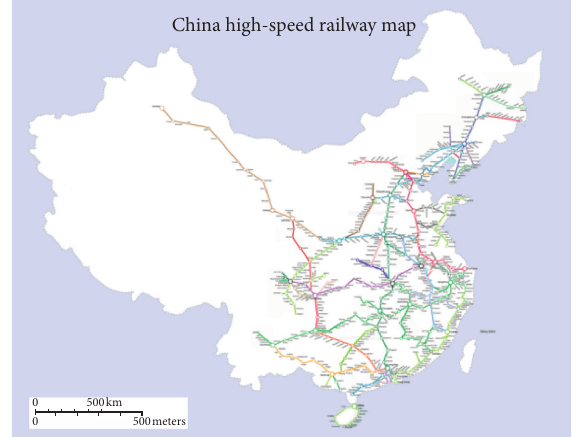
Figure 1: HSR network in China.